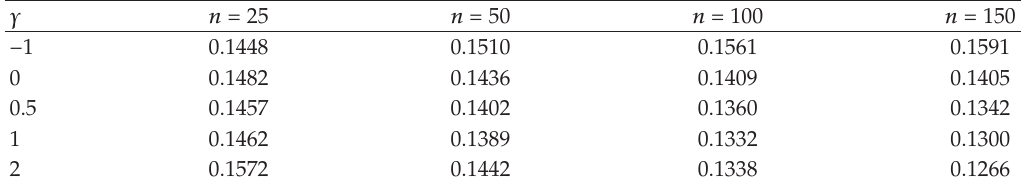
Table 11: MSE of the estimates for the exponential distribution under right censoring, 20% of contamina- tion.